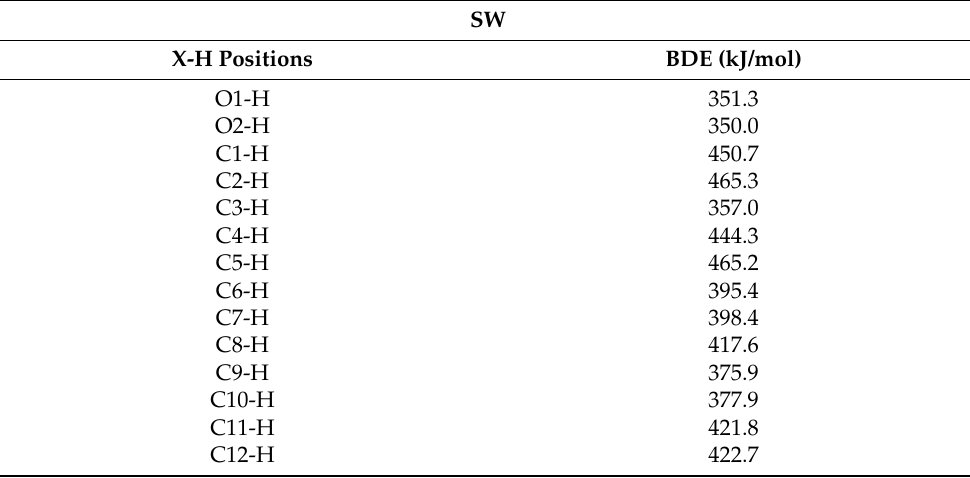
Table 1. Bond dissociation enthalpy (BDE) (in kJ/mol) for all unique C-H and O-H bonds in San- towhite (SW) calculated at the M06-2X/6-311++G(2d,2p) level of theory in gas phase.